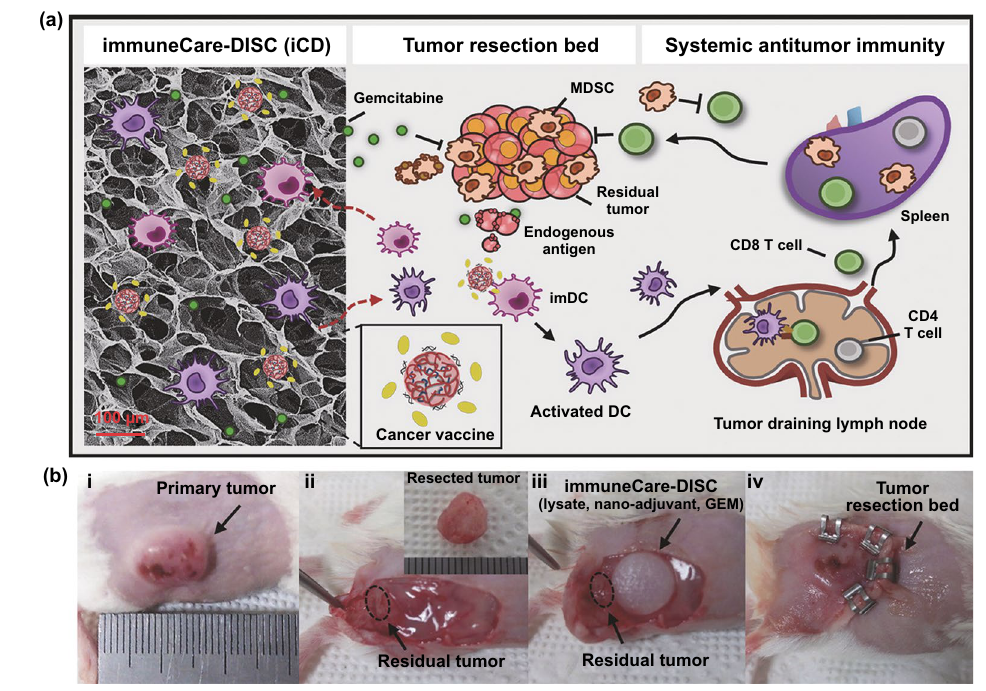
Fig. 11 a Schematic diagram showing the design of the iCD, which codelivers GEM, as an MDSC-depleting drug to revert the immunosuppres- sive microenvironment, and cancer vaccines consisting of whole tumor lysates and nanoadjuvants carrying TLR3 agonists, to provide immu- nostimulation and elicit an anti-tumor immune response. Release of the vaccine induced the infiltration, activation, and homing of DCs to the lymph nodes, which initiated an antigen-specific adaptive immune response in a host environment where tumor-induced immunosuppression was depleted by MDSCs. b Implantation approach: (i) surgery was performed after the tumor volume reached ≈300 mm3, (ii) tumor dissection mim- icking incomplete tumor removal (≈90% of primary tumor was excised), (iii) implantation of the iCD containing GEM and cancer vaccines, (iv) wound closure. Reproduced with permission from Ref.